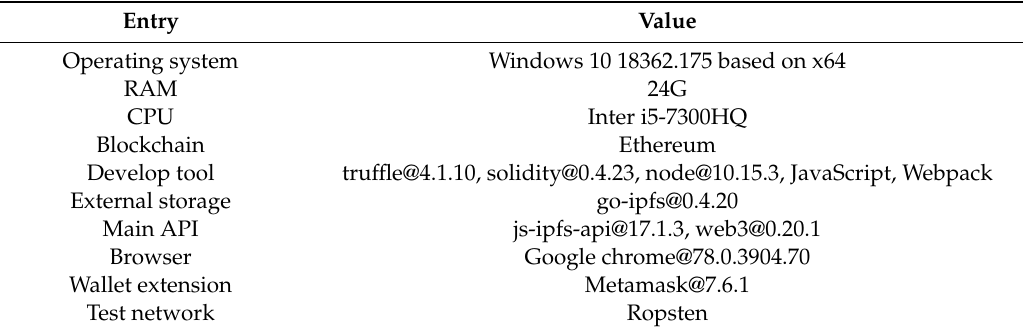
Table 4. Development environment and tools.